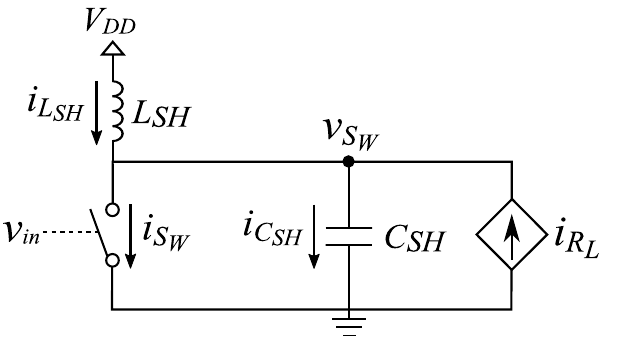
Figure 3. High Q L model of the ideal Class-E PA with finite DC-feed